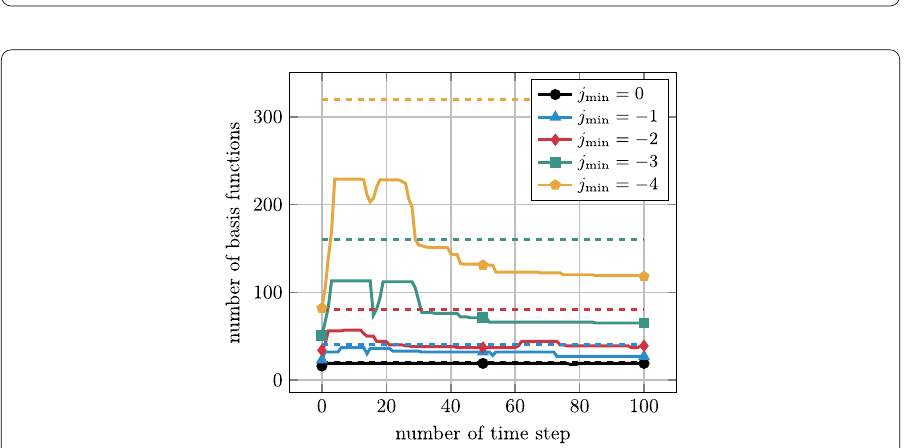
Figure 10 Error between analytical and numerical solution of the ARM (black, solid) and SSM (blue, dashed) in different norms for j max = 0